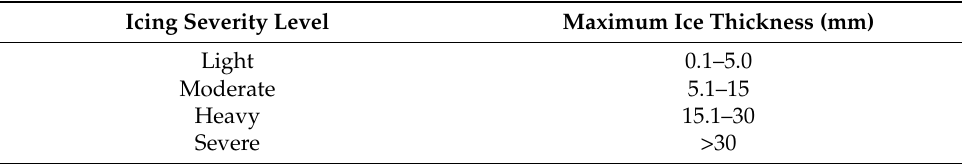
Table 2. Icing severity level based on icing thickness [37].